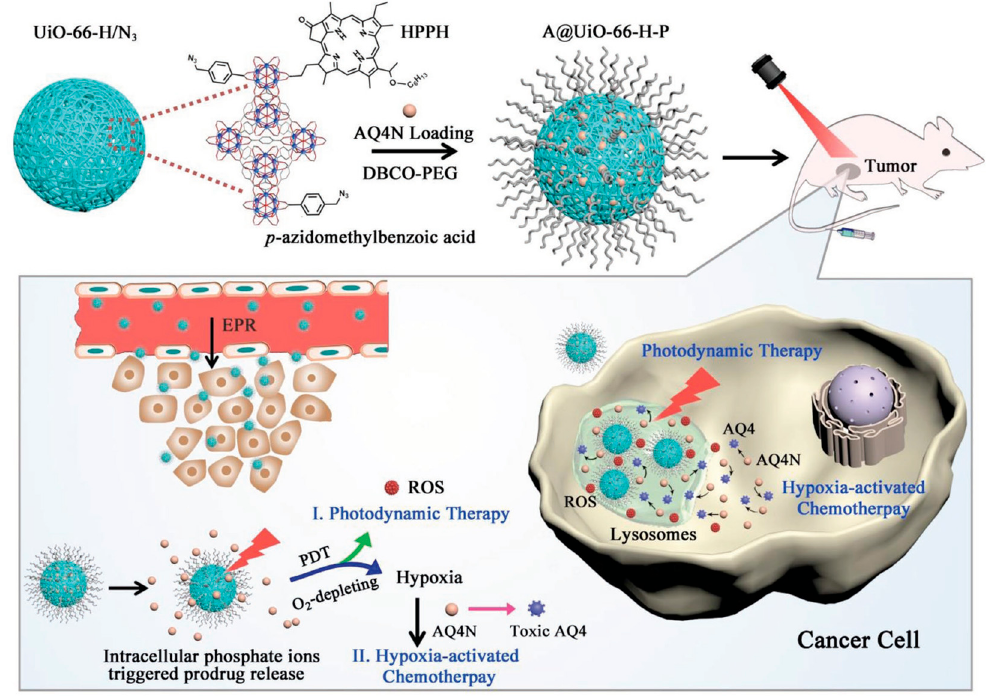
Figure 7. Synthetic procedure of A/UiO-66-H-P nanoparticles and mechanism of photodynamic therapy and hypoxia-activated cascade chemotherapy [72].